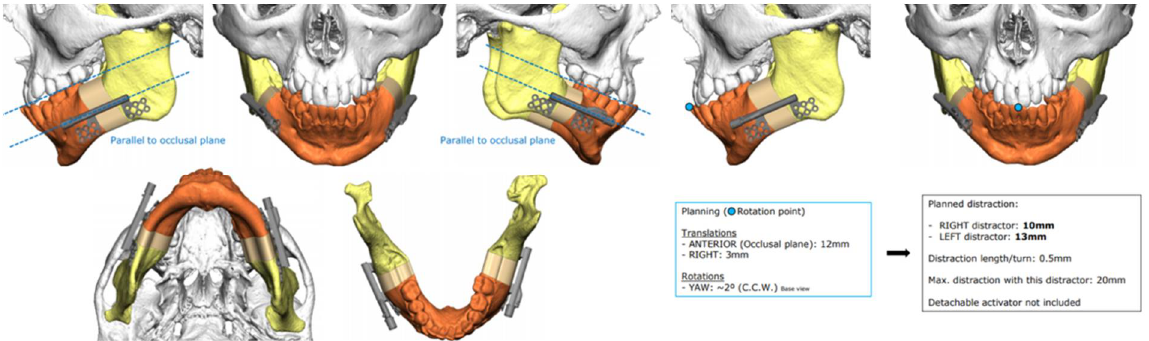
Figure 6. 3D planning of intraoral distractor position with postoperative virtual simulation of the predicted results on hard tissues after repositioning the mobilized bone structures.